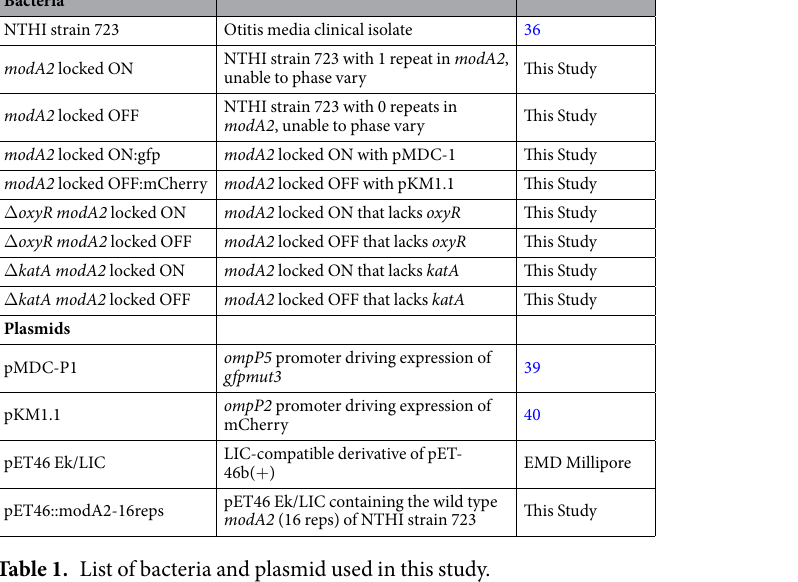
system along with current and future antimicrobials to best develop treatment or prevention strategies for the diseases caused by these pathogens. Methods